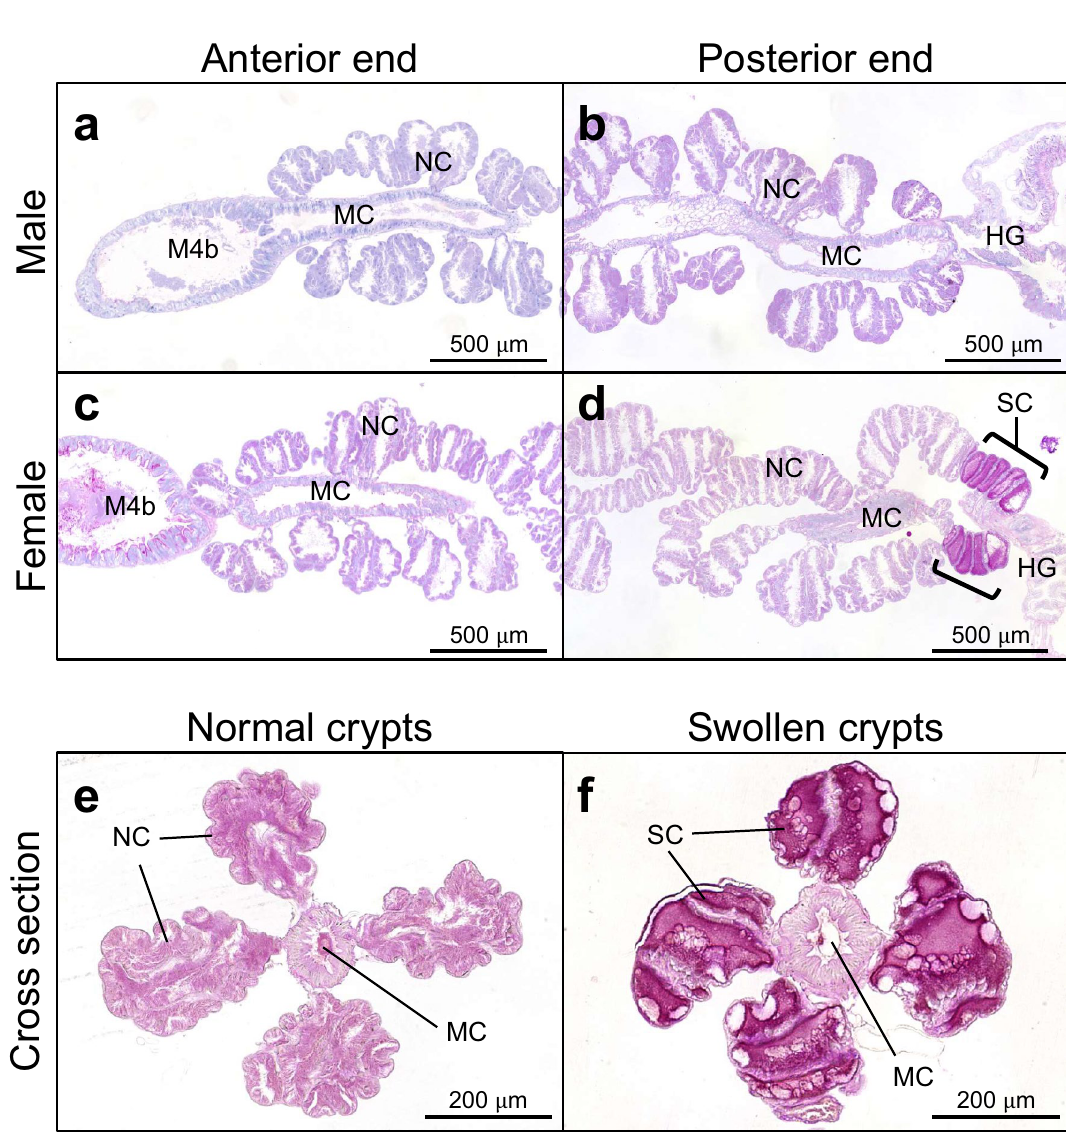
Figure 4. Localization of PAS-positive SC mucin protein in the female-specific swollen crypts of the symbiotic midgut. ( a , b ) Longitudinal tissue sections of anterior part ( a ) and posterior part ( b ) of the symbiotic midgut of an adult male. ( c , d ) Longitudinal tissue sections of anterior part ( c ) and posterior part ( d ) of the symbiotic midgut of an adult female. ( e , f ) Cross tissue sections of the normal crypts ( e ) and the swollen crypts ( f ) of the symbiotic midgut of an adult female. M4b, bulb-like region anterior to M4; NC, normal crypt; SC, swollen crypt; HG, hindgut; MC, midgut main